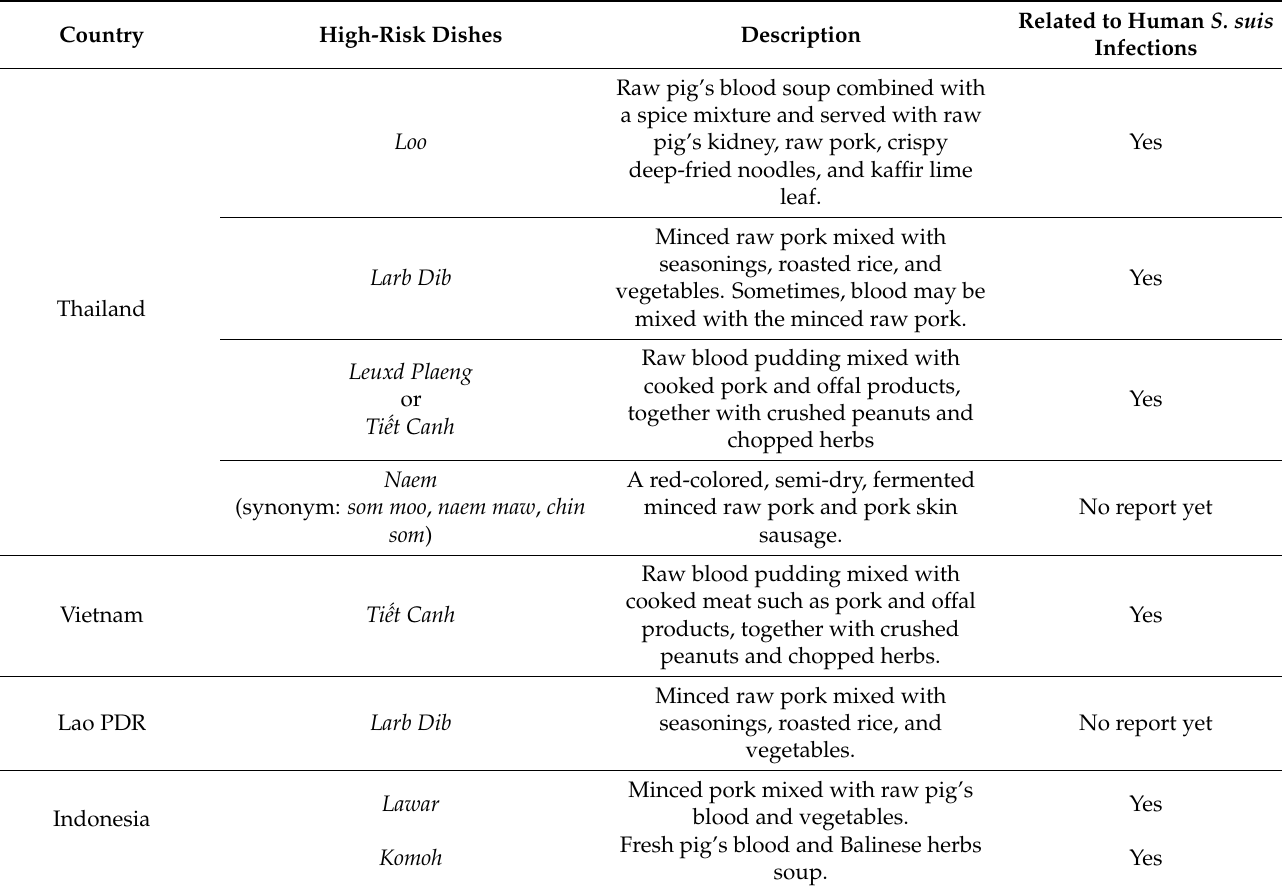
Related to Human S.